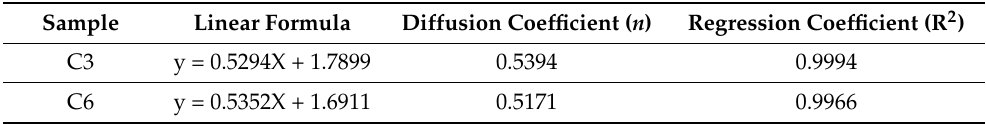
Table 2. Linear equations, regression coefficients and exponential coefficient obtained from the Peppas-Ritger model of the